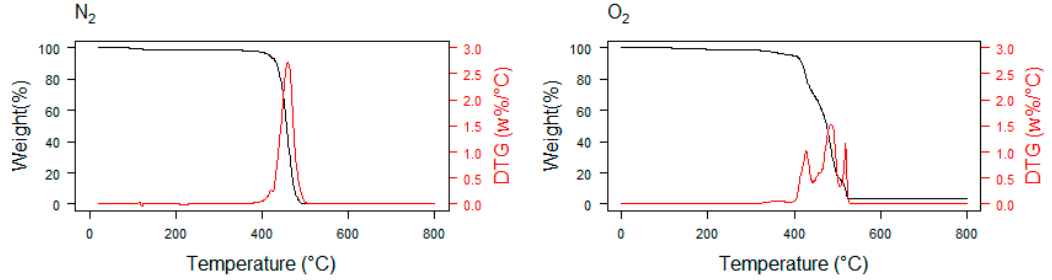
Figure 2. Decomposition of synthetic polyamide nylon 6 in nitrogen (on the left) and in oxygen (on the right).